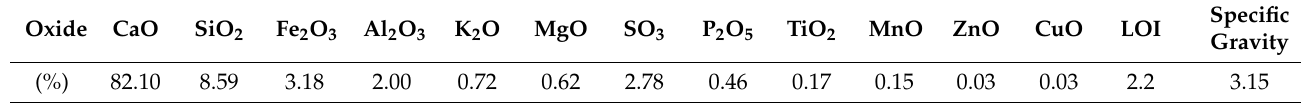
Table 1. Properties and oxide composition of ordinary Portland cement (OPC).